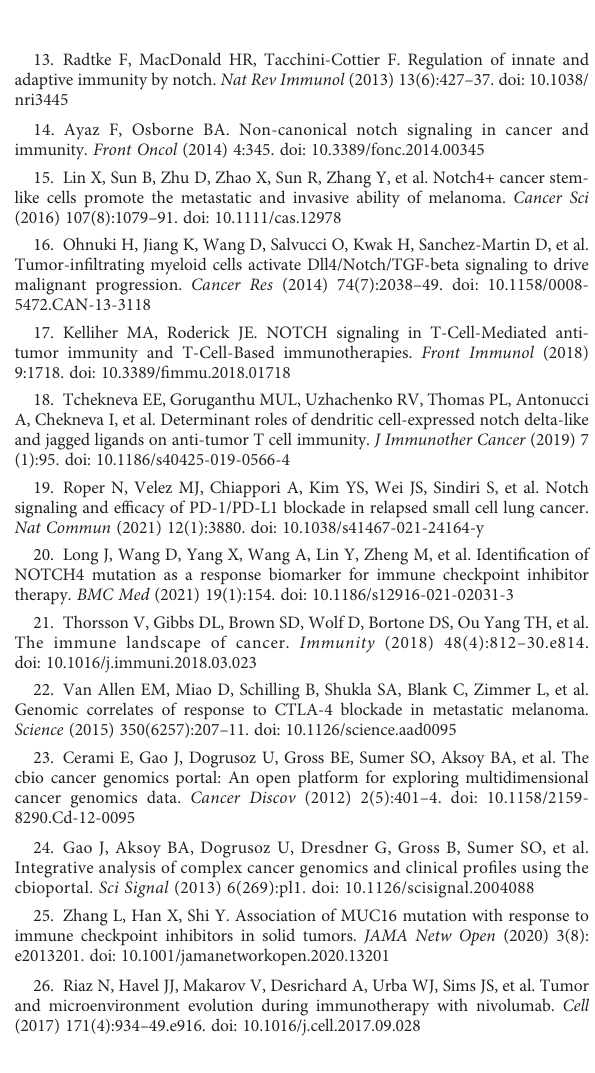
SUPPLEMENTARY FIGURE 3 The Kaplan-Meier curves of OS between NOTCH4-Mut and NOTCH4-Wt group in NRAS mutant melanoma of discovery cohort (A) and validation cohort (B)